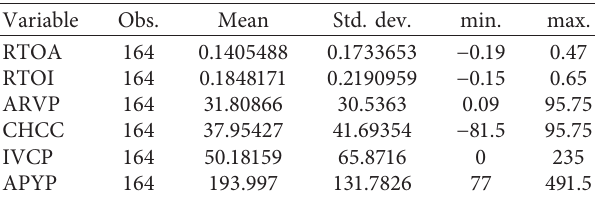
Table 1: Descriptive statistics